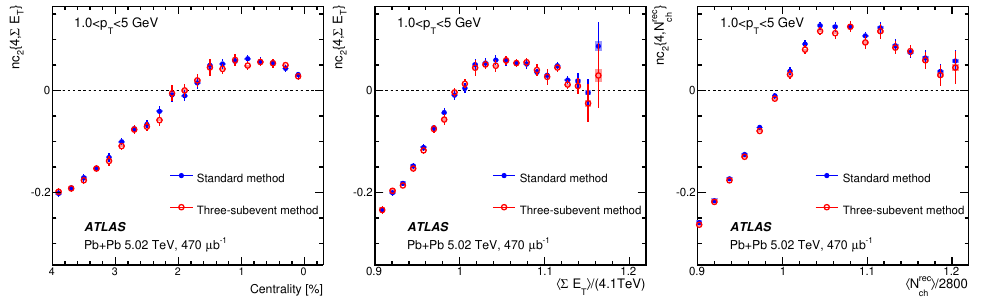
Figure 28 . The nc 2 f 4 ; (cid:6) E T g in ultra-central collisions calculated for charged particles as a function of centrality (left panel), (cid:6) E T (middle panel), and N rec (right panel) with the standard cumulant ch method and the three-subevent method. The error bars and shaded boxes represent the statistical and systematic uncertainties, respectively.